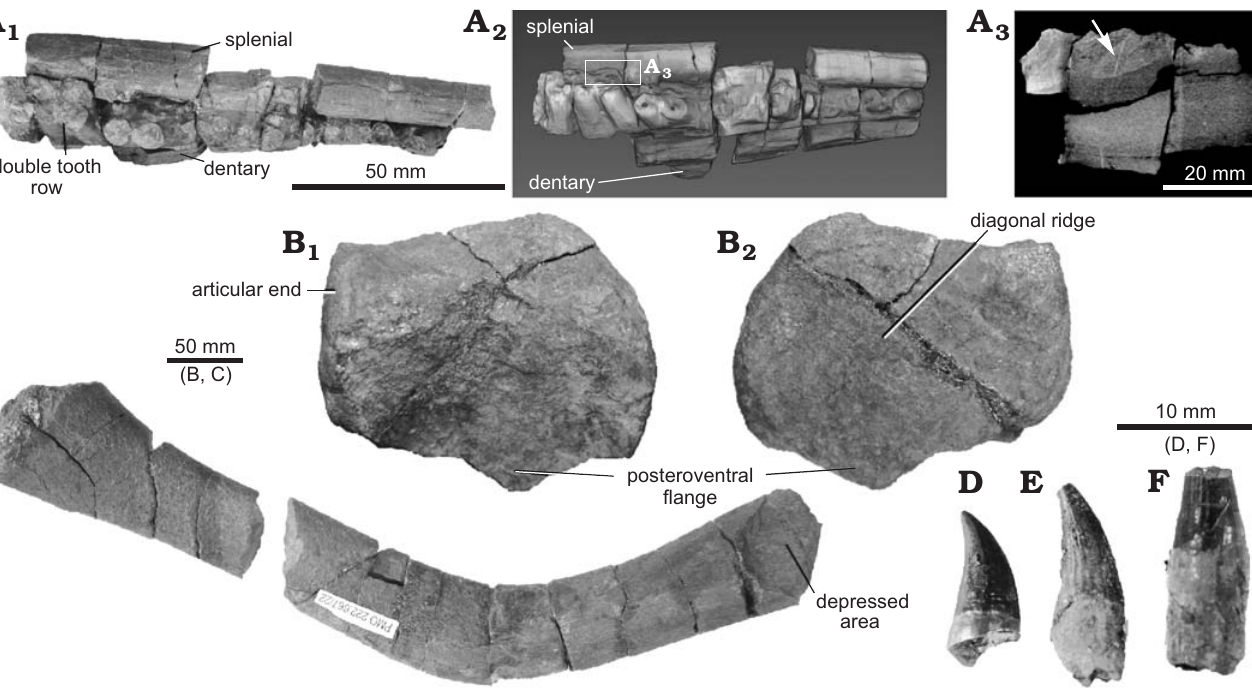
Fig. 6. Cranial elements of ophthalmosaurid ichthyosaur Keilhauia sp. ( PMO 222.667) from Spitsbergen, Svalbard, Slottsmøya Member Lagerstätte, Tithonian. A . Lower jaw fragment in dorsal view (anterior to the left). A 3 , detail of inner structures with arrow showing position of ventral-pointing tooth from the upper jaw, anterior to the right, in dorsal view. B . Right articular in medial (B 1 ) and lateral (B 2 ) views. C . Hyoid in lateral or medial view (anterior to the left). D – F . Teeth. Photographs (A 1 , B–F), μ CT scan images (A 2 , A 3